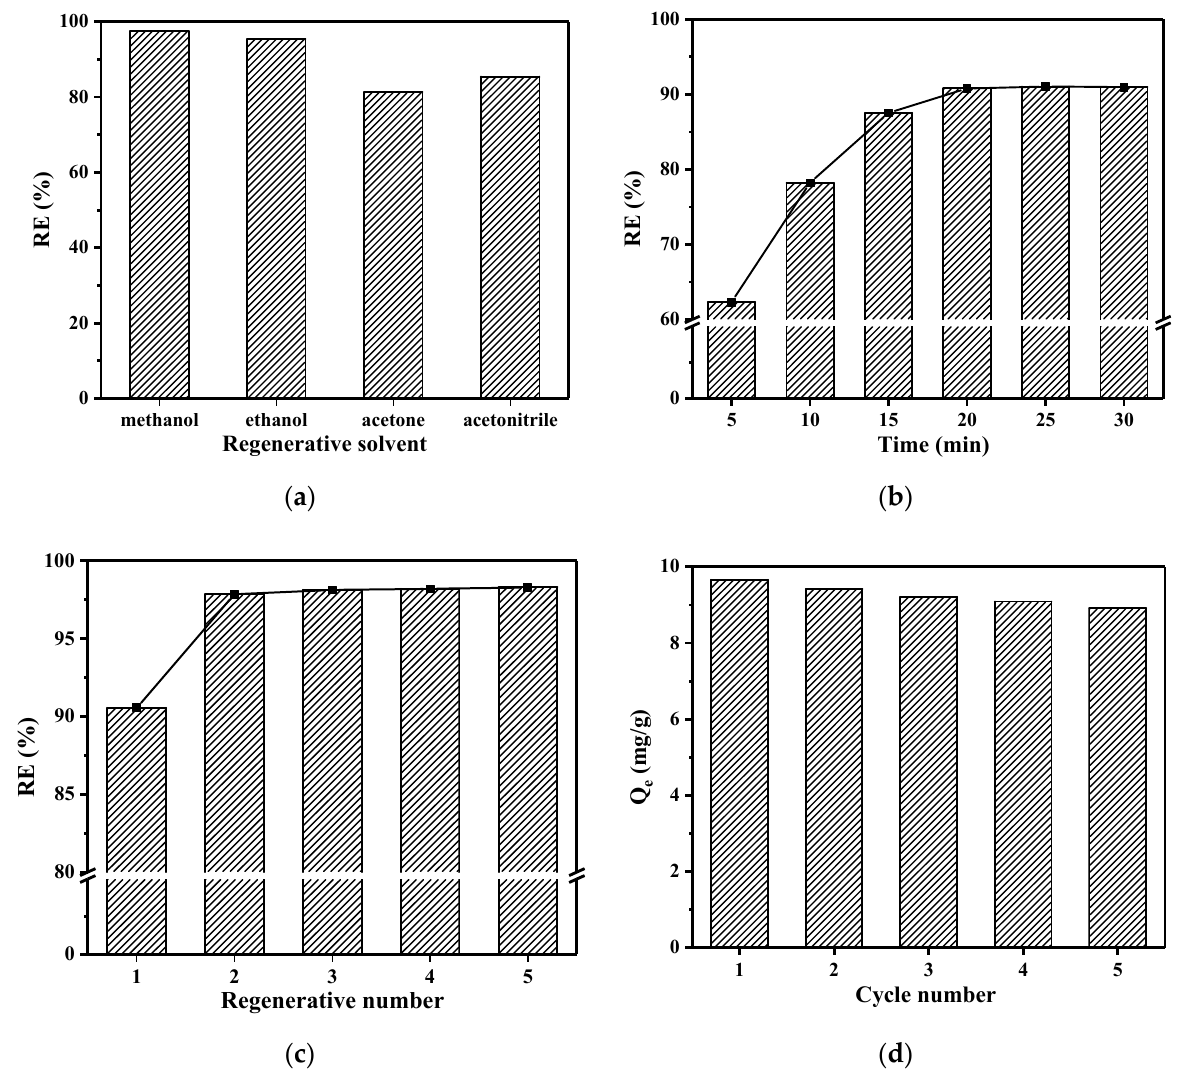
Figure 10. The effects of: ( a ) regenerative solvents, ( b ) regeneration time, and ( c ) regeneration number on regeneration of MMIPs. ( d ) Reusability of MMIPs on adsorption of E2. Conditions: [E2] 0 = 5 mg/L, [MMIPs or MNIPs] 0 = 0.5 g/L, T = 30 °C, and pH = 6.0.